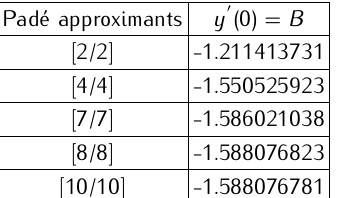
0 Initial slopes B = u (0) for various Padé approximants Padé